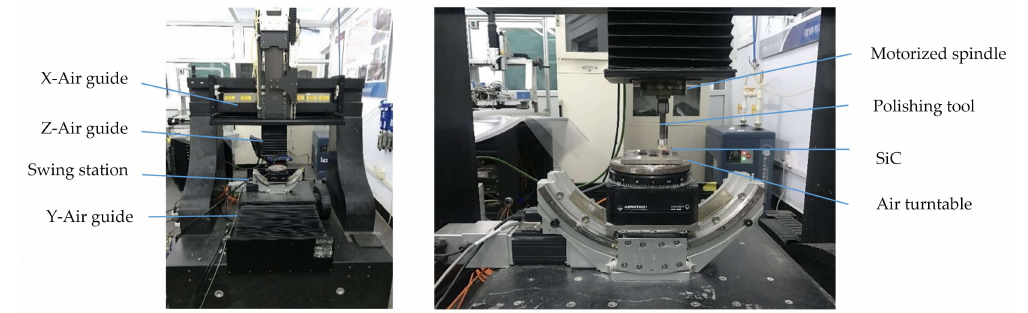
Figure 10. Optical photograph of experimental